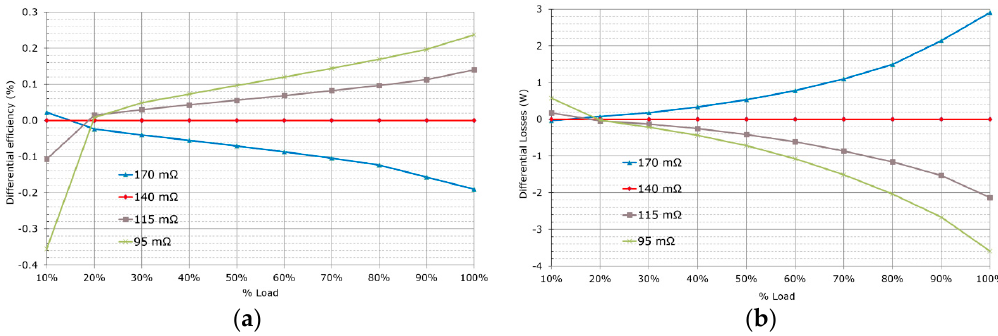
Figure 14. Efficiency for different HV MOSFETs R DS(on) : ( a ) differential efficiencies; ( b ) differential Figure14. E ffi ciencyfordi ff erentHVMOSFETsR DS(on) : ( a )di ff erentiale ffi ciencies; ( b )di ff erentiallosses. losses.